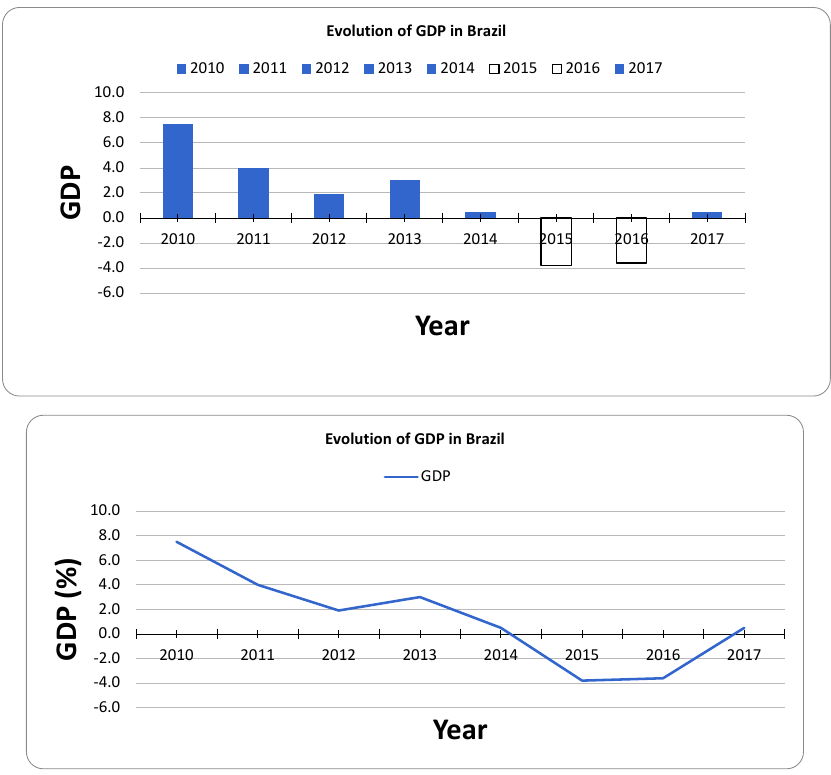
Fig. 1. Evolution of the Brazilian GDP until 2017 (Martello,